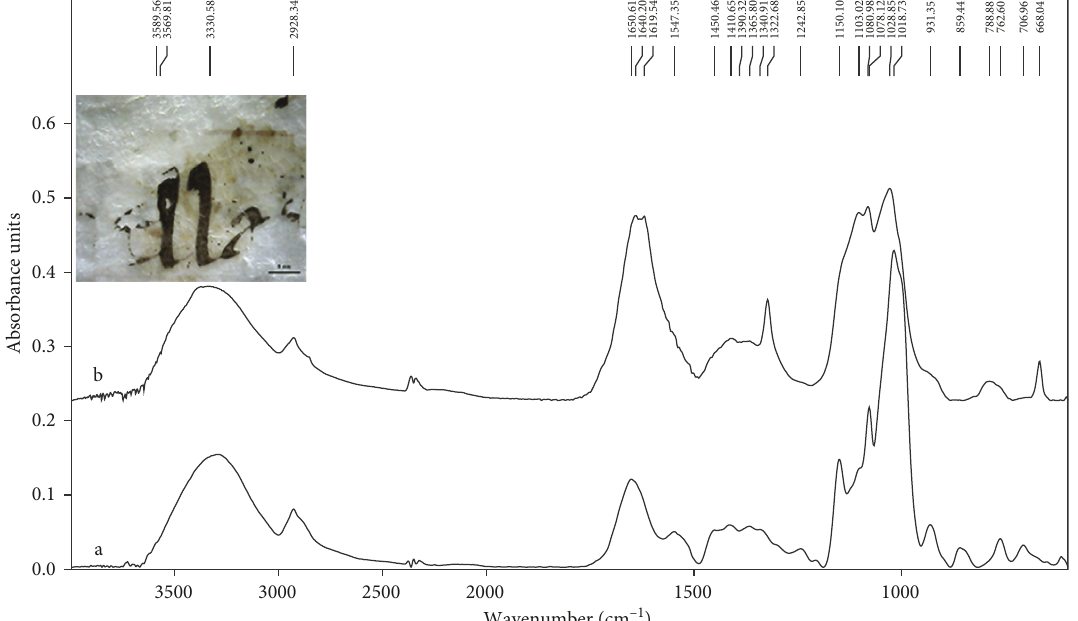
Figure 5: ATR-FTIR spectra of two black inked areas: (a, b) Parch. 38. The inset shows the yellowing effect due to a superficial treatment.